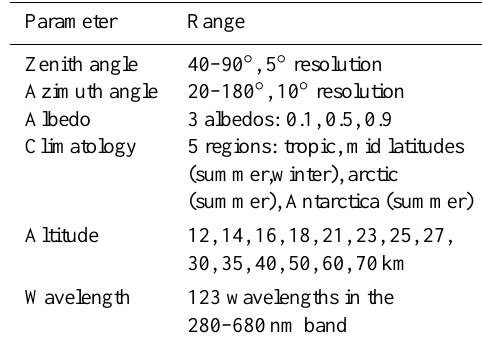
Table 2. Siro look-up table